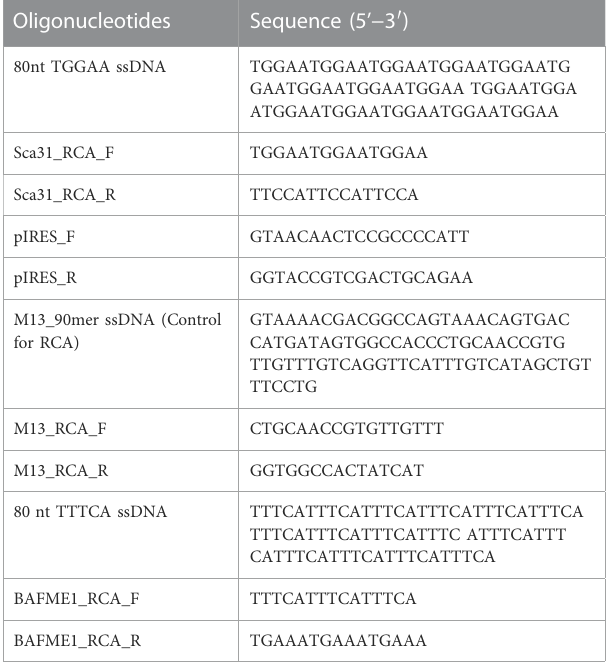
TABLE 1 Sequences for oligonucleotides used in ssDNA template preparation, rolling circle ampli fi cation, PCR ampli fi cation check and Sanger sequencing.